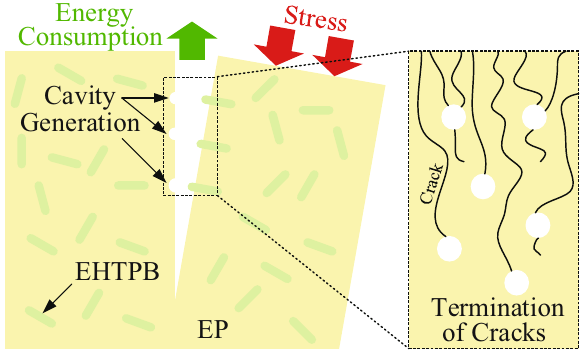
Figure 9: Mechanism of EHTPB to improve the mechanical properties.